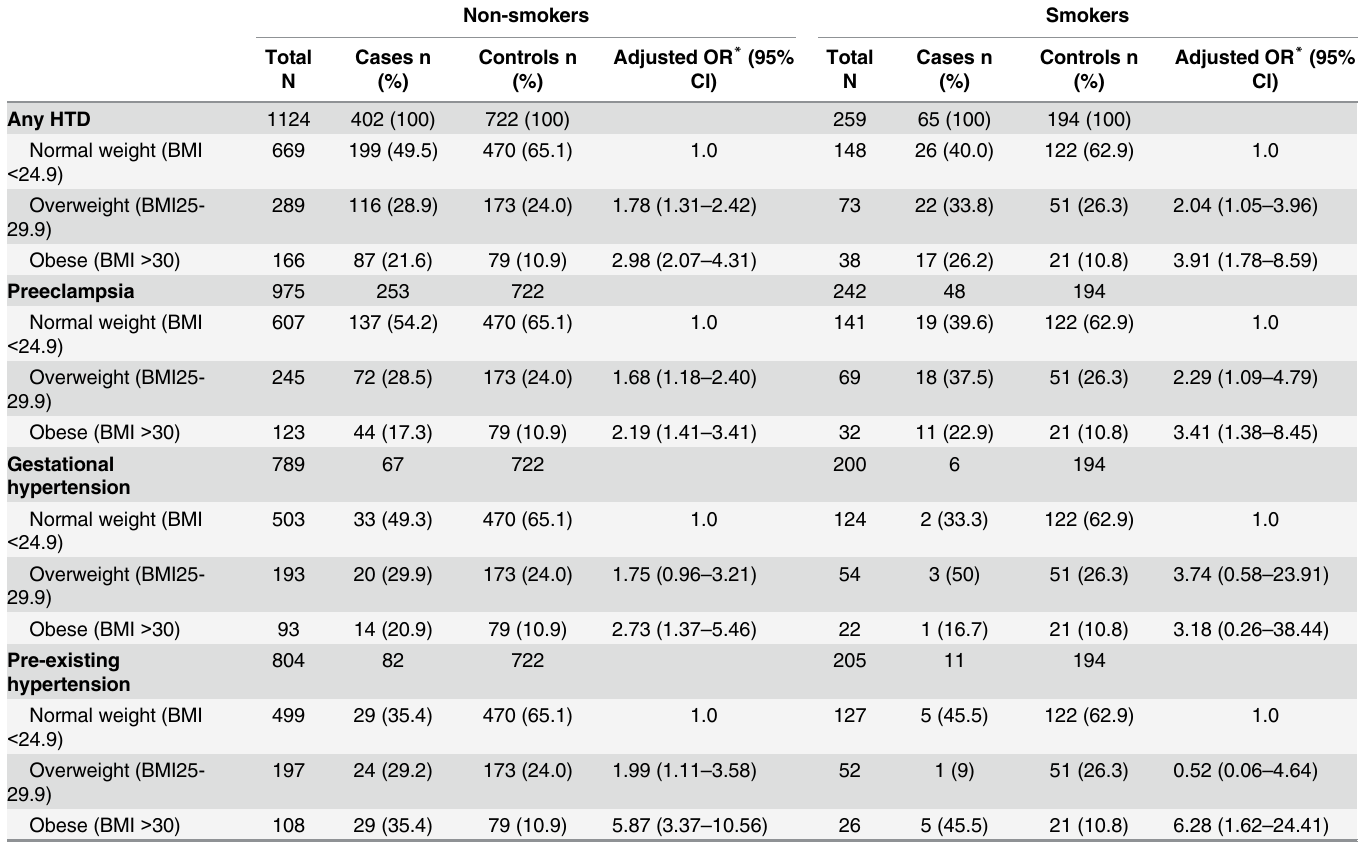
Table 3. Association of Body Mass Index with Hypertensive Disorders during Pregnancy Stratified by Smoking